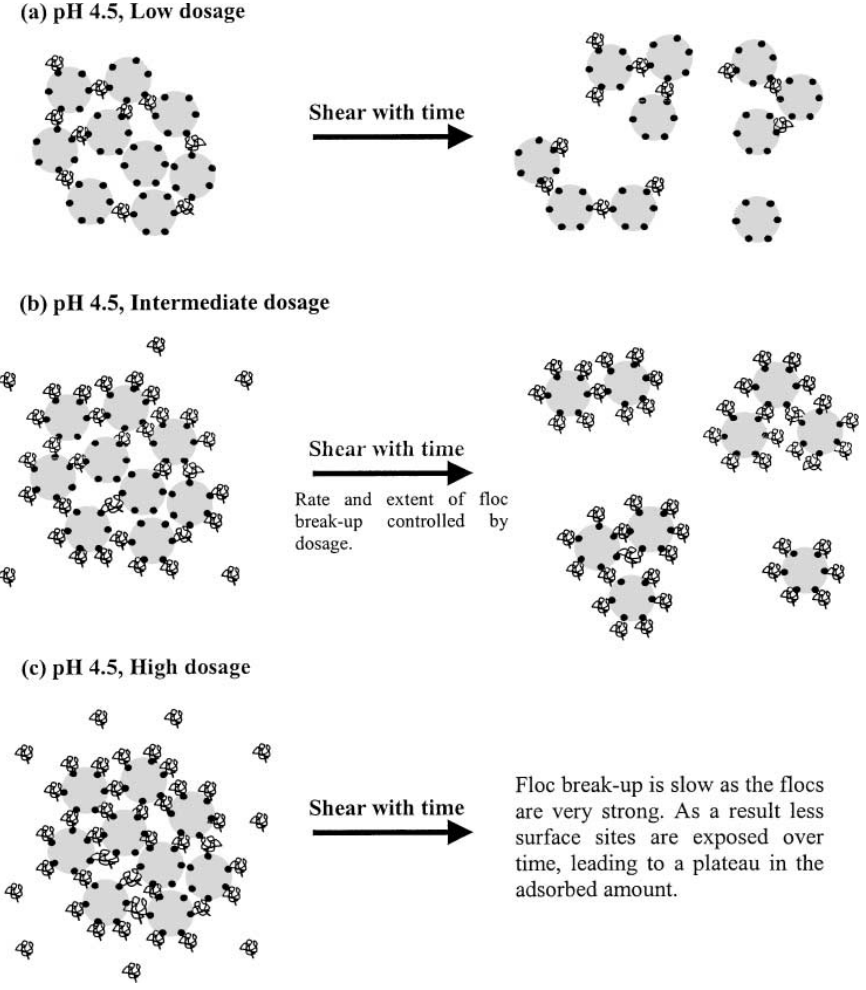
Figure 4. Flocs behavior under constant shear as a function of flocculant dosage at pH 4.5 (Reproduced from Taylor et al. (2002) [60] , Copyright © 2021, with permission from the publisher, License No. 5217491437114).